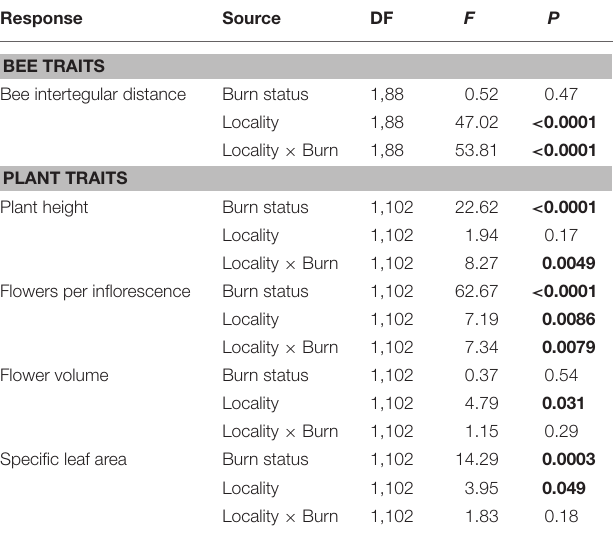
TABLE 4 | Results of two-way ANOVAs testing the effects of wildfire (i.e., burn status as burned or unburned), locality (i.e., Helena or Paradise) and their interaction on the mean intraspecific variation in bee and plant traits of all individuals and species measured across